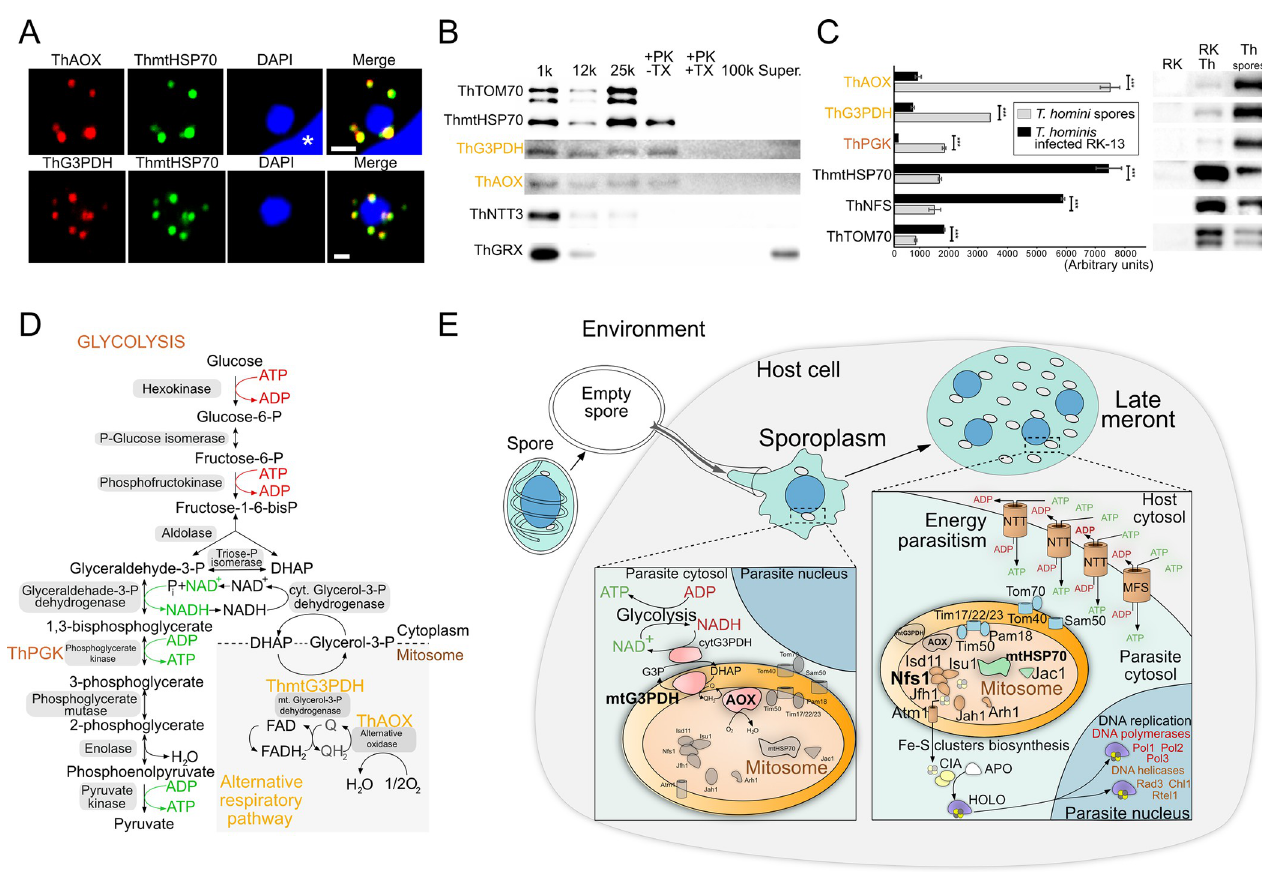
Fig 1. The components of the microsporidian alternative respiratory pathway localise inside T . hominis mitosome and are enriched in T . hominis spores rather than intracellular stages from infected host rabbit kidney cells. (A) Confocal immunfluorescence images of single T . hominis cells inside the infected host RK13 cells. Monolayer of T . hominis infected host cells was fixed with methanol-acetone and double labelled with the affinity purified polyclonal rabbit antibodies against T . hominis AOX (red, top panel) or T . hominis mtG3PDH (red, bottom panel) and polyclonal rat antisera raised against T . hominis mtHSP70 (green). Nuclei of the parasite and the host (asterisk) were labelled with DAPI (blue), scale bars correspond to 1 μ m. ( B) Fractionation by differential ultracentrifugation was performed on lysates of T . hominis infected RK13 cells lysed with a glass homogeniser. Western blots of protein fractions were probed with the affinity purified antibodies against T . hominis AOX and mtG3PDH, as well as polyclonal sera against characterized T . hominis proteins that localize to: outer mitosomal membrane (ThTOM70) [13], mitosomal matrix (mtHSP70) [10], cell membrane (ThNTT3) [5], and cytosol (ThGRX) [13]. Mitosome- enriched 25,000g (25k) fraction was treated with proteinase K (+PK–TX), or proteinase K and Triton X-100 (+PK +TX). Supernatant fraction (super.) is a supernatant after the final 100,000g (100k) centrifugation. ( C) Analyses of the intensities of the specific bands detected in protein extracts from purified T . hominis spores (Th spores), T . hominis infected RK13 cells (RKTh) and non-infected RK13 (RK) cells control. The western blots were probed with affinity purified antibodies against ThAOX or ThmtG3PDH, and polyclonal sera against ThPGK, ThmtHSP70, ThNFS, and ThTOM70. The intensities of the detected bands were measured with FIJI [31]. Significantly different values were indicated (T-test; ��� , P � 0.001). Error bars represent standard deviation of intensities values measured in three replicate western blotting experiments. 10 μ g (BCA assay) of each protein extract were loaded onto gels (S3 Fig). (D) Hypothetical model of the ATP producing pathway consisting of glycolysis and mitosomal alternative respiratory pathway based on bioinformatics analyses of T . hominis genome [8,15]. The mitosomal alternative respiratory pathway (light orange) provides the mechanism for oxidation of cytosolic NADH to NAD + ; and the NAD + serves as an electron acceptor required to maintain generation of ATP in glycolysis. (E) Model of the main mitosomal function at different stages of the T . hominis life cycle. The intracellular stage of the life cycle is initiated by the injection of the spore’s contents (sporoplasm) into the host cell, followed by the growth of the parasite cell into a large multinucleate proliferative cell (meront). The inset figures show the magnified section of the parasite cells containing a mitosome (orange). Mitosomes of the spores and the sporoplasms contain the machinery for oxidation of NADH to NAD + via the alternative respiration (AOX and mtG3PDH), required for the generation of the ATP in the glycolytic pathway (glycolysis) [15]. Later stages of the T . hominis life cycle can utilize the membrane nucleotide transporters (NTTs) to steal ATP from their host [3–5], while using their mitosomes mainly for the generation of the Fe-S clusters [11,13] required by essential proteins such as DNA polymerases and helicases [13]. The Fe-S clusters are inserted into the apoproteins (APO) via the cytosolic Fe-S cluster assembly system (CIA) forming a functional holoenzyme (HOLO) [13]. Mitosomal proteins enriched in the spores are coloured in pink (AOX, mtG3PDH) whereas the protein detected across the parasite life cycle are coloured in brown (Fe-S biosynthesis including NFS), green (chaperone proteins e.g. mtHSP70), or blue (mitosomal protein import including TOM70). Fe-S containing nuclear proteins involved in DNA replication (DNA polymerases and helicases) were indicated in violet.